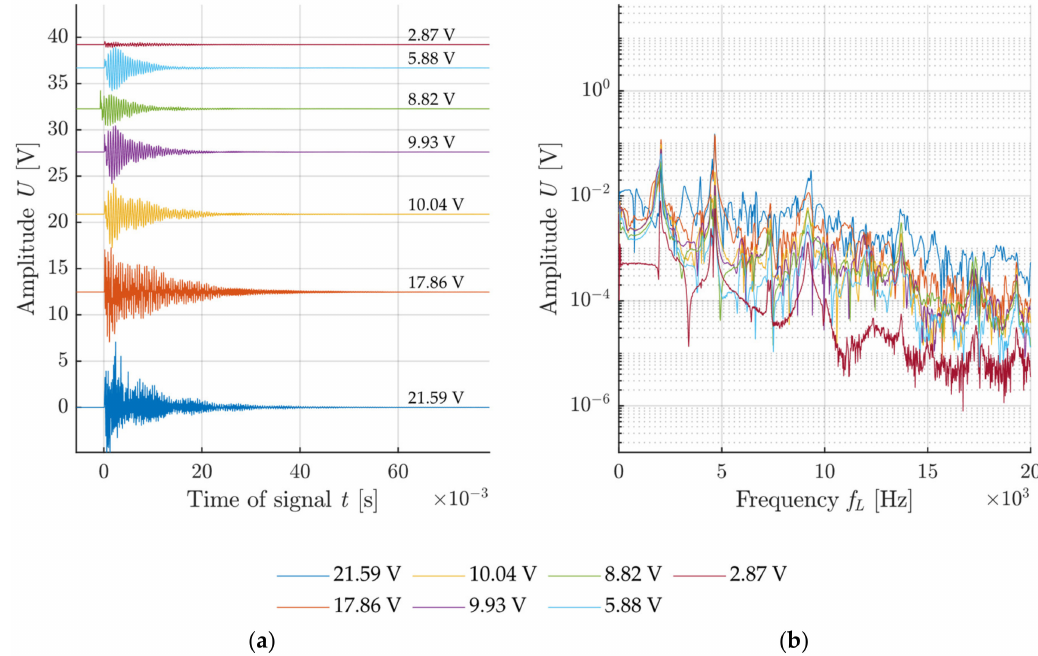
Figure 12. Example of impact with a hammer with a sharp tip without a handle: ( a ) Signals from the sensor attached to test specimen with rising impacting force; ( b ) frequency spectrum of recorded signals.